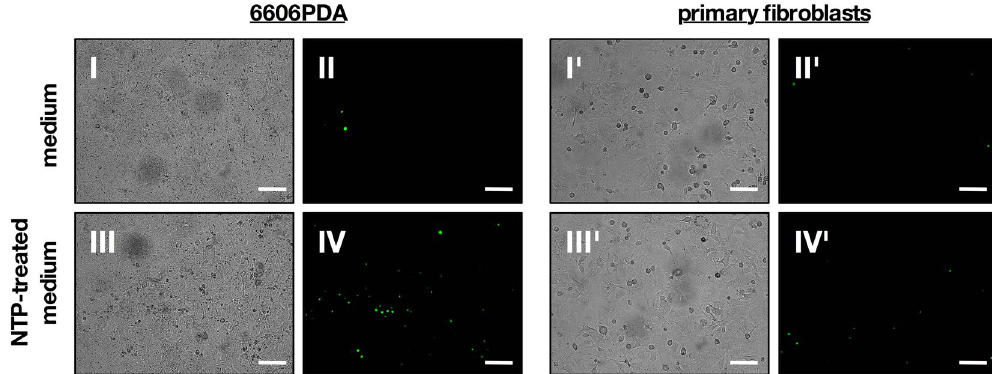
Figure 2. Directly applied NTP as well as NTP-treated medium induced apoptosis more effectively in 6606PDA. 6606PDA cells (left panel) or primary, murine fibroblasts (right panel) were exposed to argon gas- treated medium (control) or NTP-treated medium. After an incubation of 24 h, cells were imaged for activated caspases 3/7 by fluorescence microscopy. Representative images of two independent experiments are shown. Scale bars represent 100 µ m.